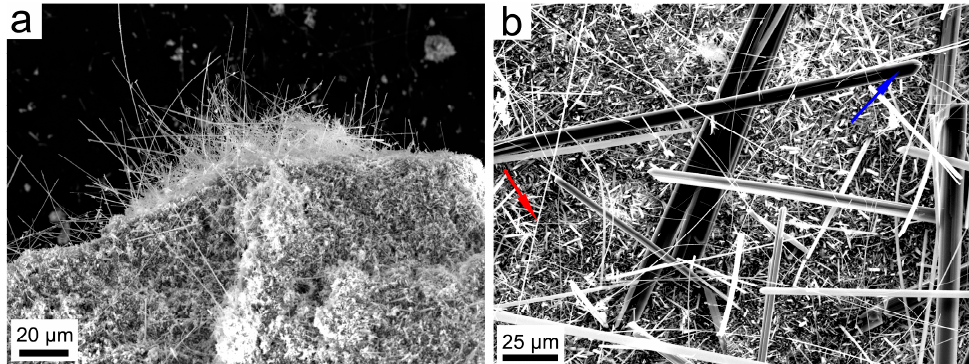
Figure 5. ( a ) Secondary electron SEM images of Ni-doped tremolite fi bers run TN8 (800 °C, 2.4 kbar, 16 day); ( b ) note the curvature of the thin Ni-doped tremolite fi bers (red arrow) and wider Ni-doped tremolite fi bers (blue arrow).